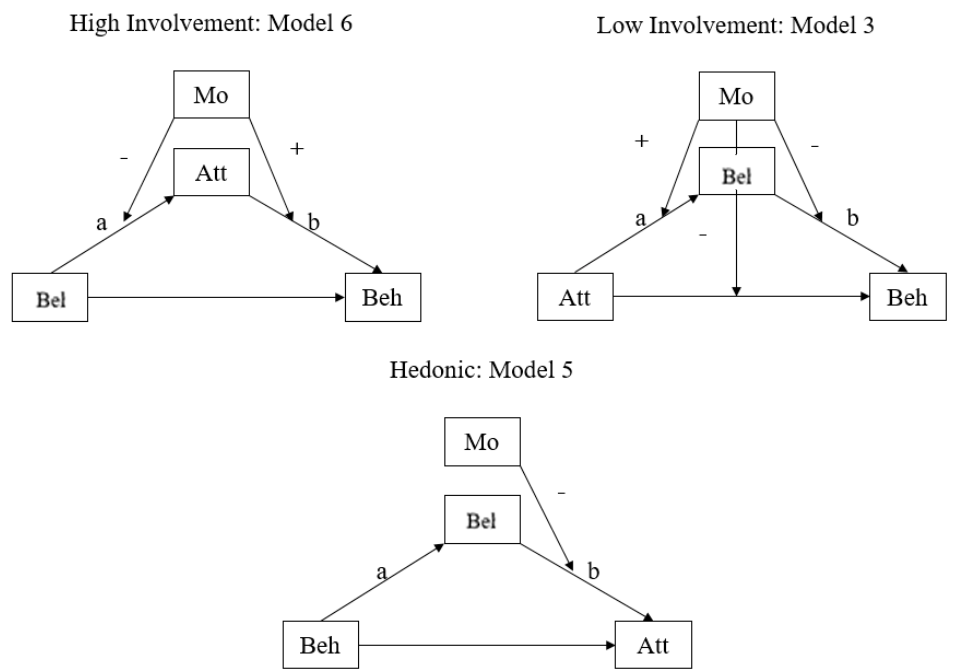
Table 6. Government Trust Model in Japan.